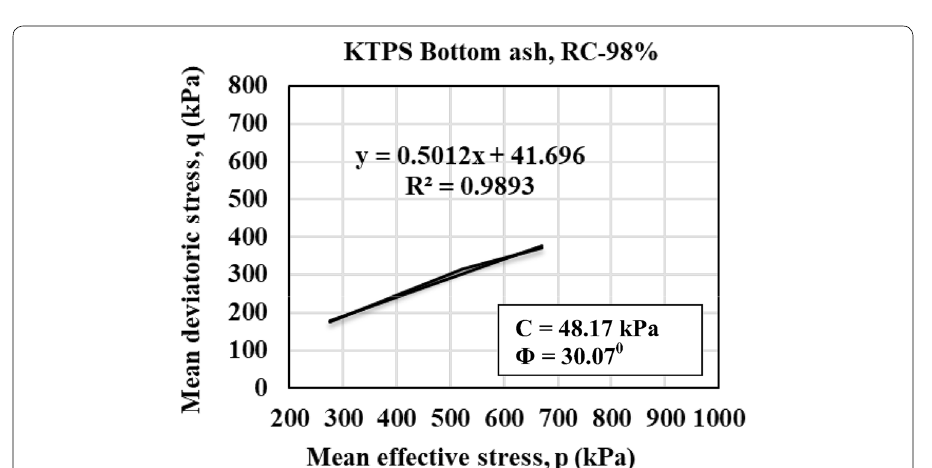
Fig. 27 p–q diagram of KTPS bottom ash at